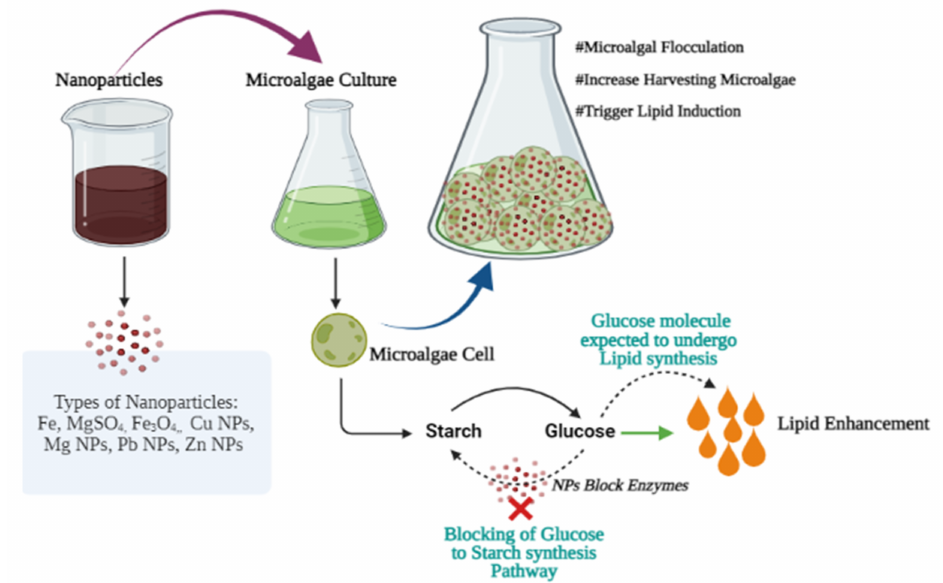
Figure 2. Nanoparticles trigger lipid synthesis and harvesting